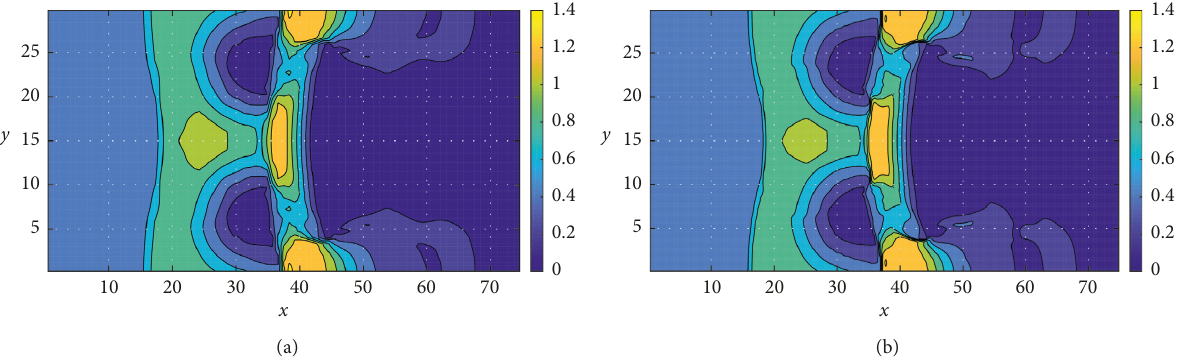
Figure 13: Contour plots of h using 85